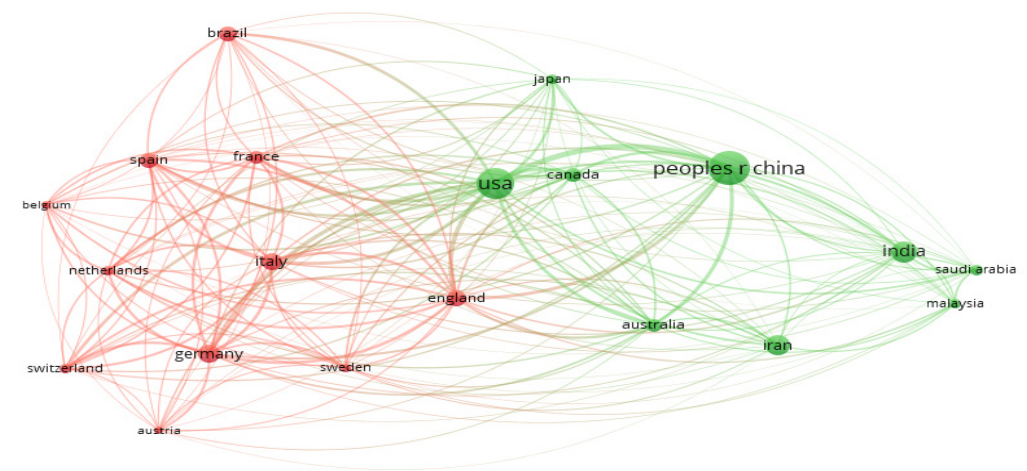
Figure 11. Research collaboration network amongst top 20 countries in terms co-authored docu- ments (2019–2021).